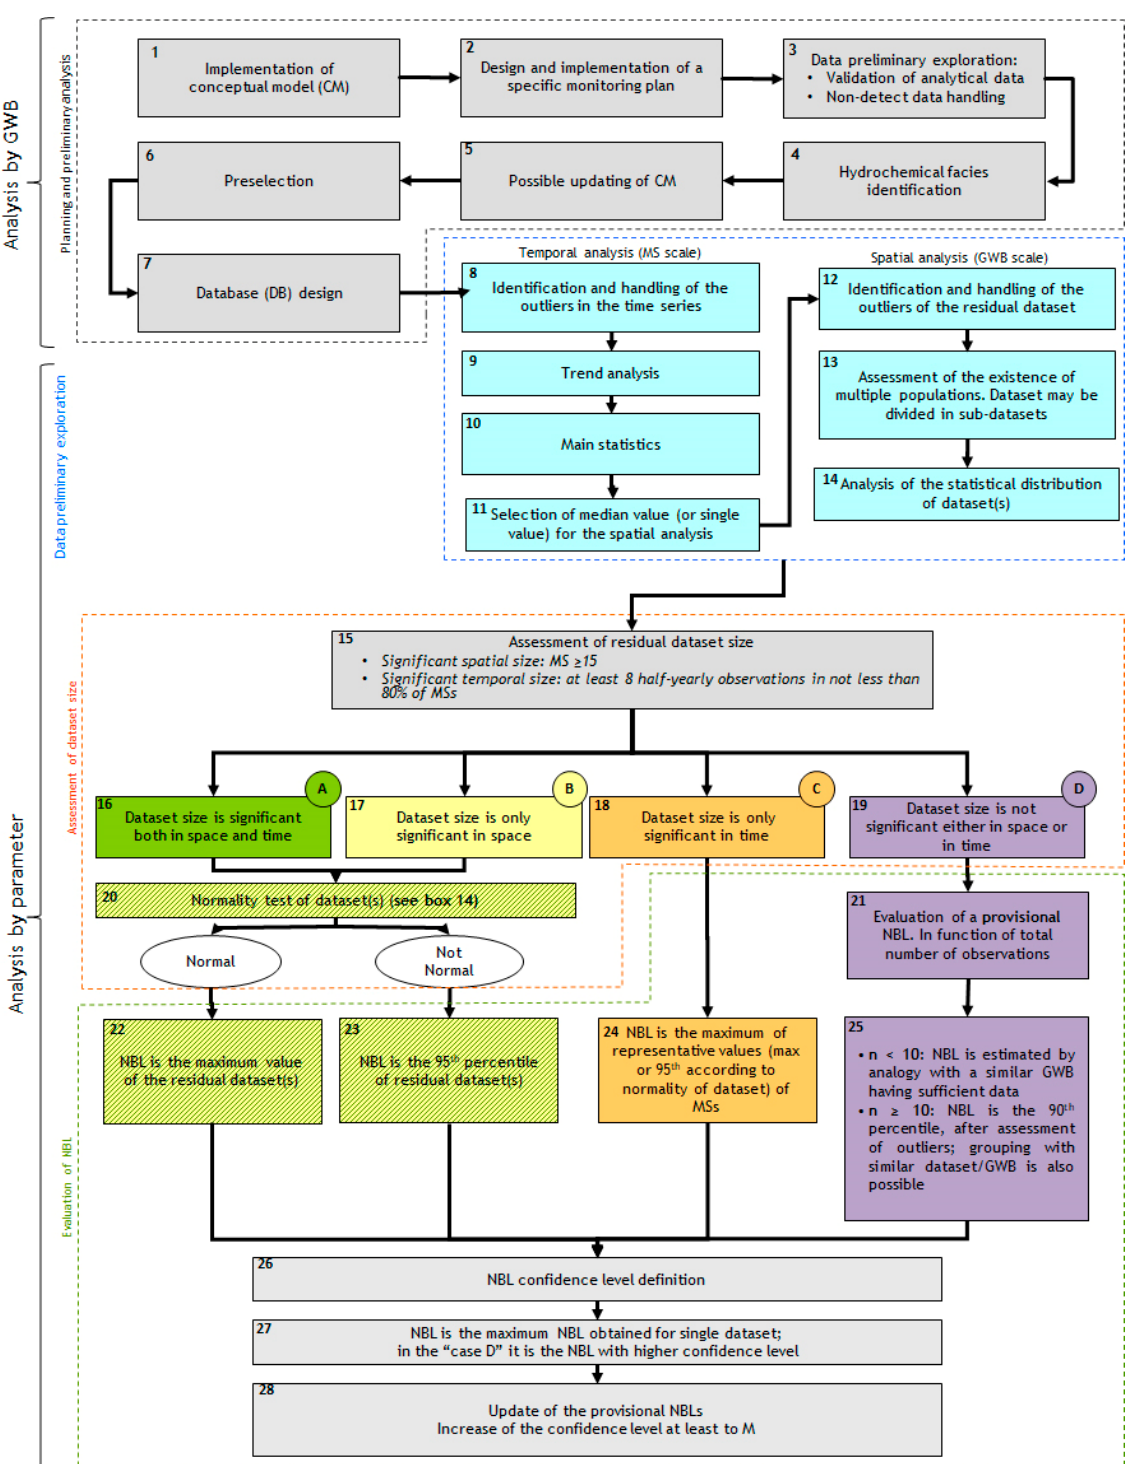
Figure 1. Italian Guidelines: Scheme of the procedure for the natural background levels (NBLs) assessment at the Ground- water Body (GWB) scale [23].